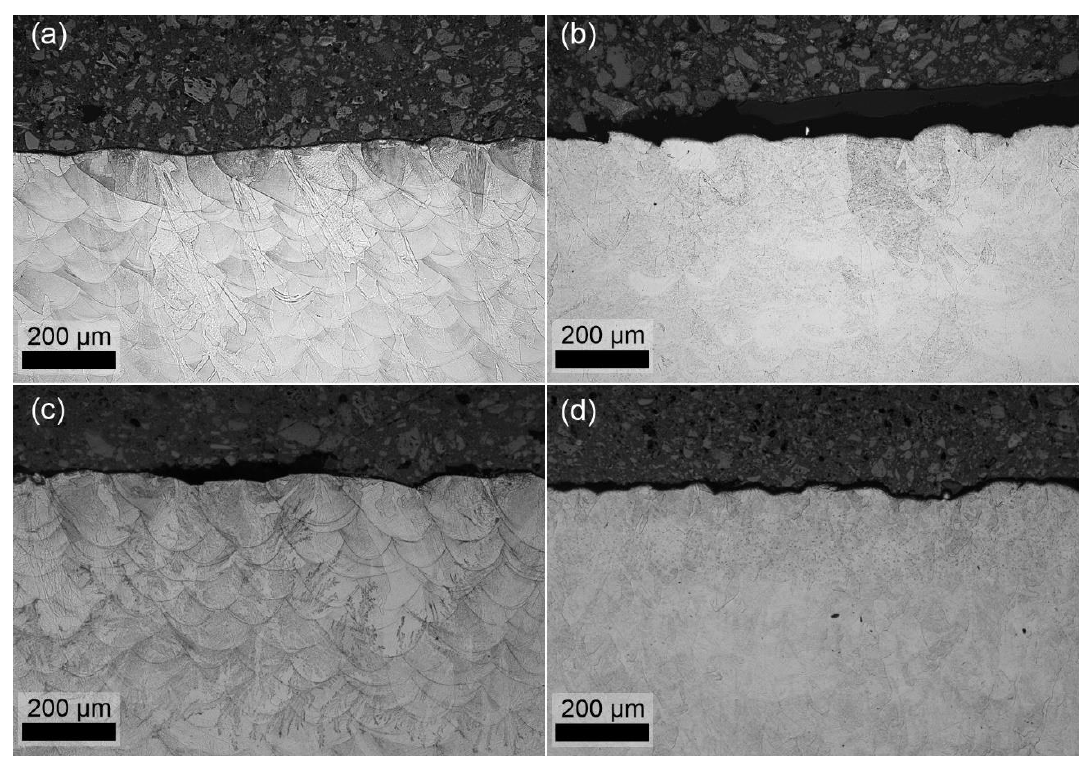
Figure 9. Optical micrographs of ( a ) AsB sample and ( b ) AsB HT after first corrosion test, and ( c ) AsB sample and ( d ) AsB HT after second corrosion test.